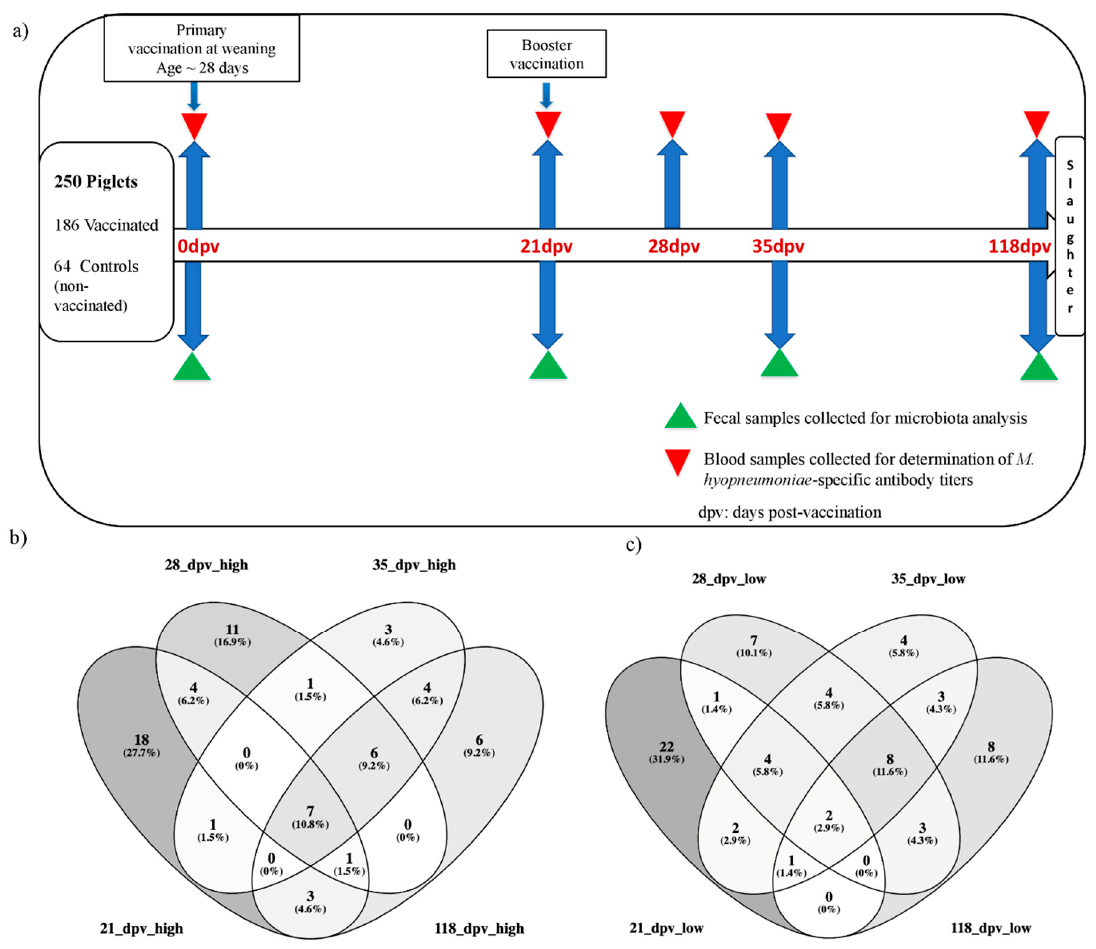
Figure 1. Study design, vaccination, fecal and blood sampling protocol, and groups of pigs classified as High or Low responders. ( a ) Protocol design and sampling. ( b ) Venn diagram showing shared and unshared groups of pigs classified as High responders based on antibody titers determined at different post-vaccination time points, ( c ) Venn diagram showing shared and unshared groups of pigs classified as Low responders based on antibody titers determined at different post-vaccination time points. Dpv; days post-vaccination.